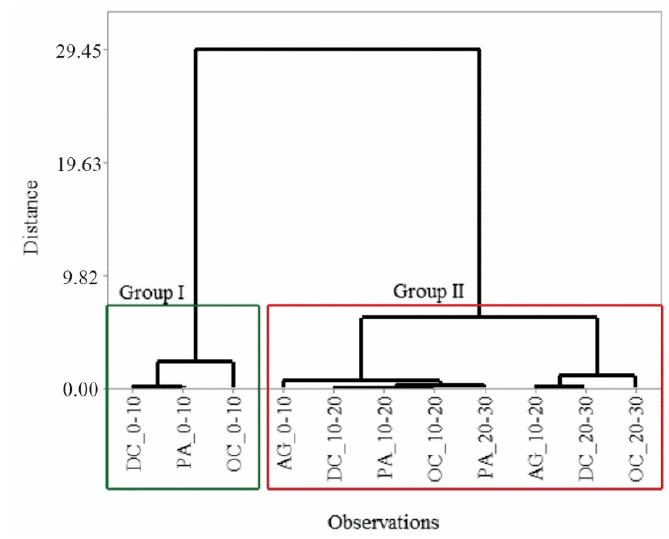
Figure 6. Similarity of the attributes of TN and TOC stock for the four land-uses: dense caatinga (DC), open caatinga (OC), pasture (PA) and agriculture (AG).